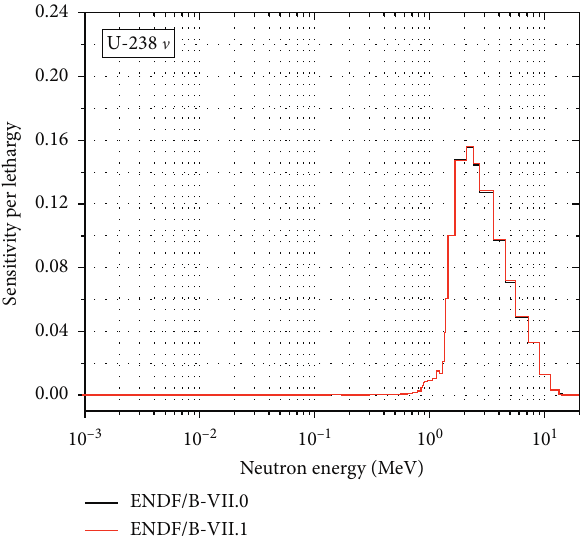
Figure 7: Energy-dependent sensitivities of k section.